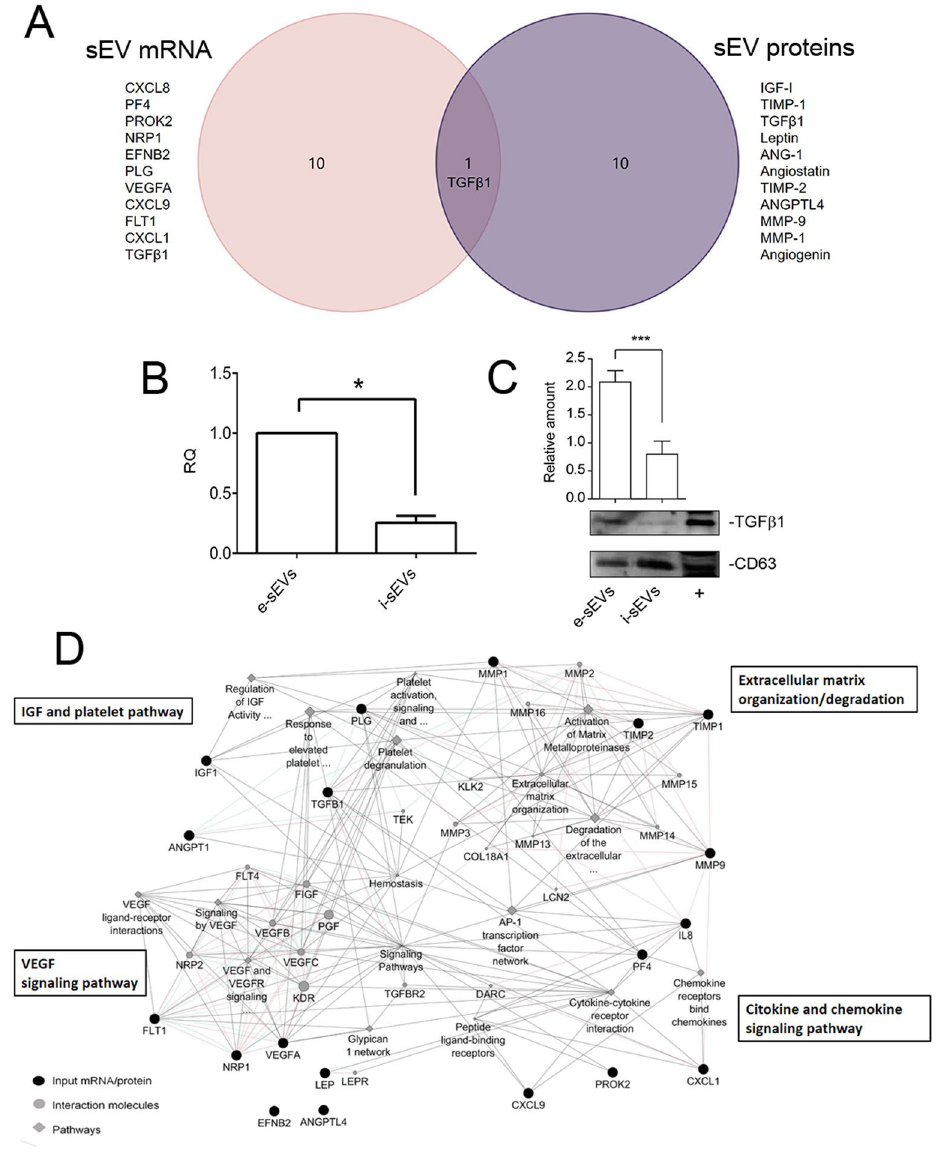
Figure 5. e-sEV angiogenic mRNA and protein content. ( A ) Venn diagram to show the first 11 angiogenic mRNAs and proteins expressed by e-sEVs. TGF β 1 was commonly detected as mRNAs and proteins. Data were analyzed by Funrich V3 tool. ( B ) RT-PCR was used to detect TGF β 1 mRNA in e-sEV cargo. RT-PCR data are expressed as relative quantification (RQ) ± SD ( * p < 0.05) (n = 4). ( C ) e-sEV were analyzed by Western Blot analysis for TGF β 1 content and normalized to CD63 ( n = 4) ( *** p < 0.001). Mesangial cells were used as positive control ( + ). ( D ) Network analysis of pathways positively correlated with e-sEV transcripts and proteins. Pathways positively correlated are reported in the boxes. Data were obtained by GeneMANIA analysis performed on